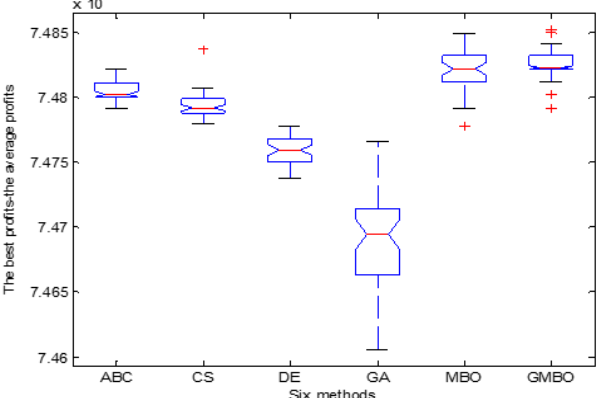
Figure 17. Boxplot of the best values on KP14 in 50 runs.